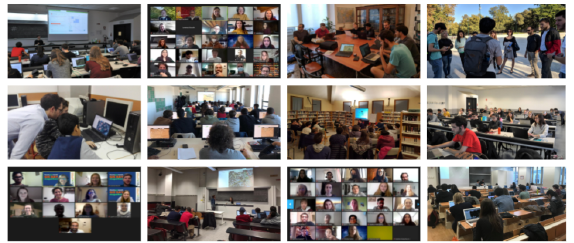
Figure 2. PoliMappers activities.